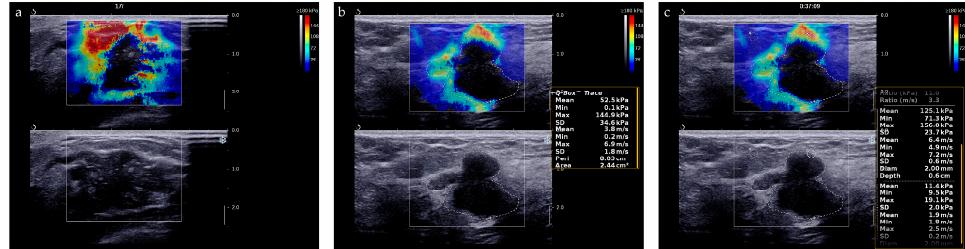
Figure 4. SWE evaluation of breast lesions. ( a ) A breast lesion with “stiff rim” sign on SWE image; ( b ) E ‐ max, E ‐ mean, E ‐ min, and E ‐ sd is automatically calculated by the system after we traced the entire target lesion. ( c ) E ‐ ratio is automatically calculated by the system after two ROIs with a diameter of 2 mm were identified at the same depth as that of the lesion.